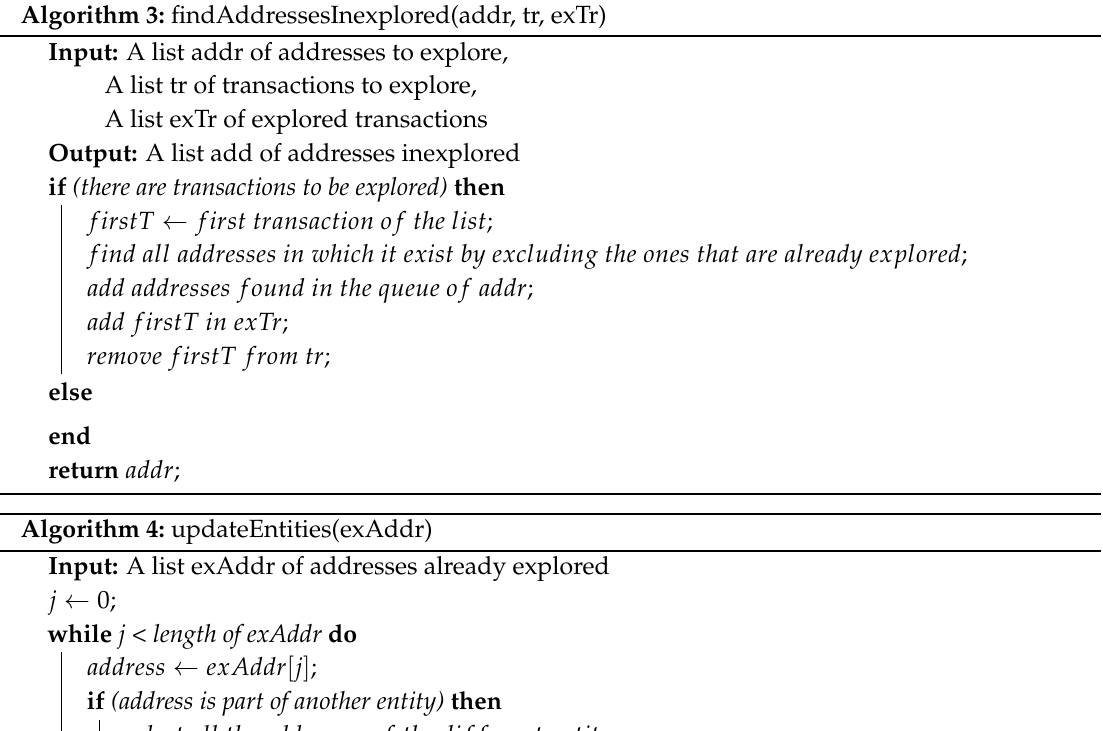
Algorithm 3: findAddressesInexplored(addr, tr,